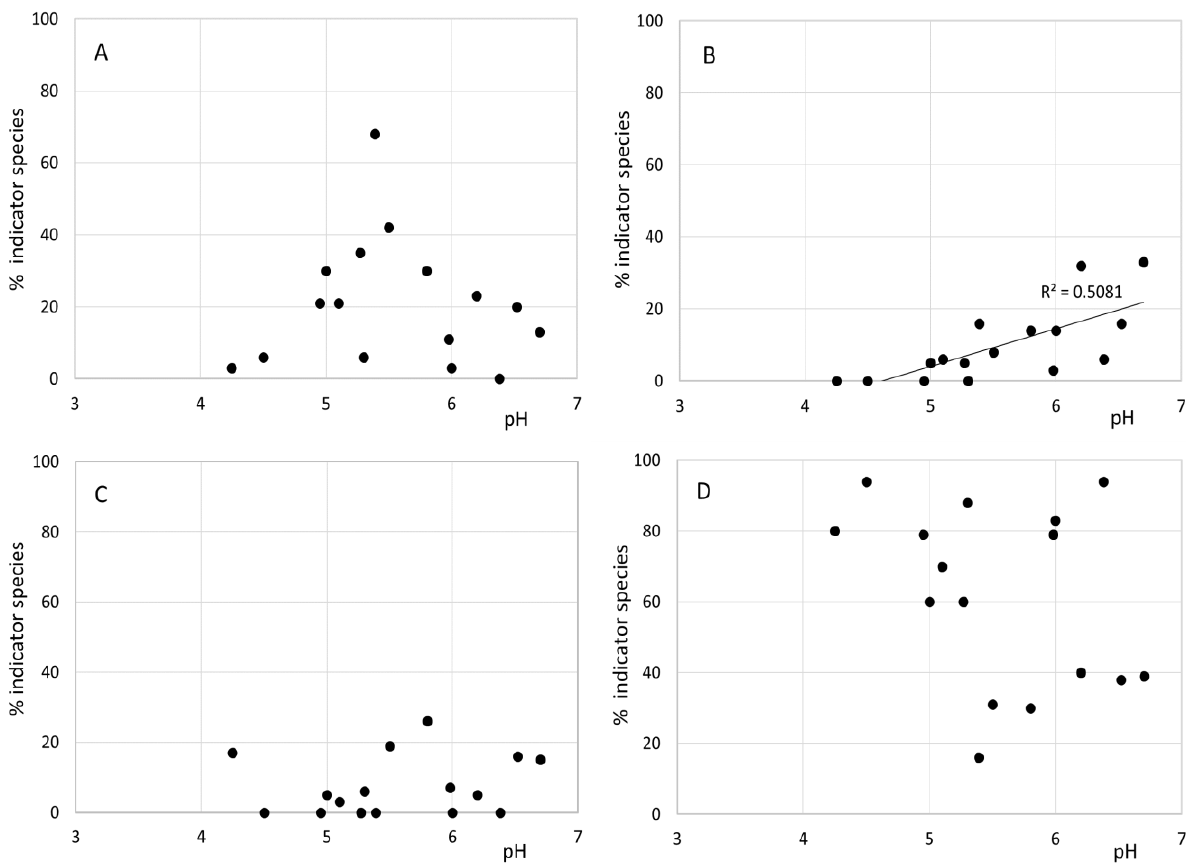
Figure 7. The relationship between the percentage of indicators of mineral soil influence (A) Sumpfigkeit , (B) Quelligkeit , (C) Bruchmoorigkeit , (D) mire expanse and indifferent (y-axis) and pH (x-axis). The regression line in (B) shows a statistically significant